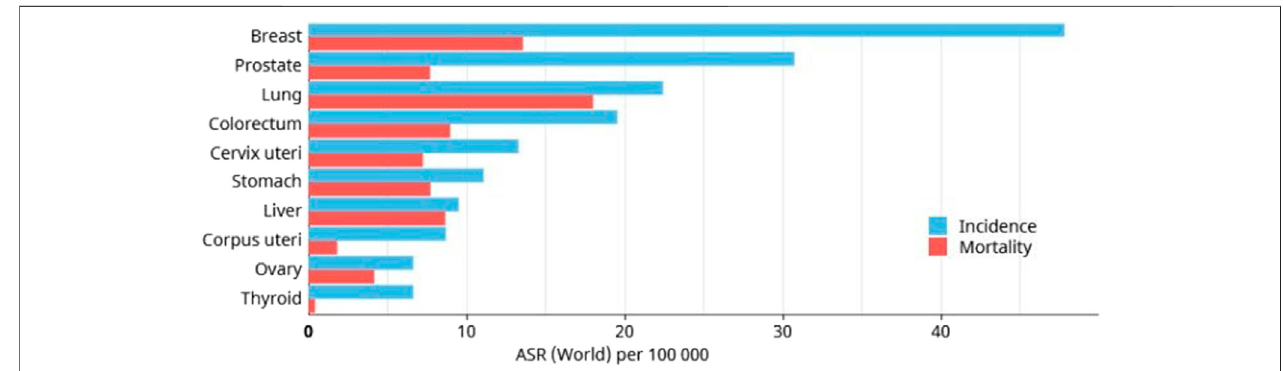
FIGURE 1 | GLOBOCAN 2020 estimate of global incidence and mortality rates of different cancers, excluding non-melanoma skin cancer.